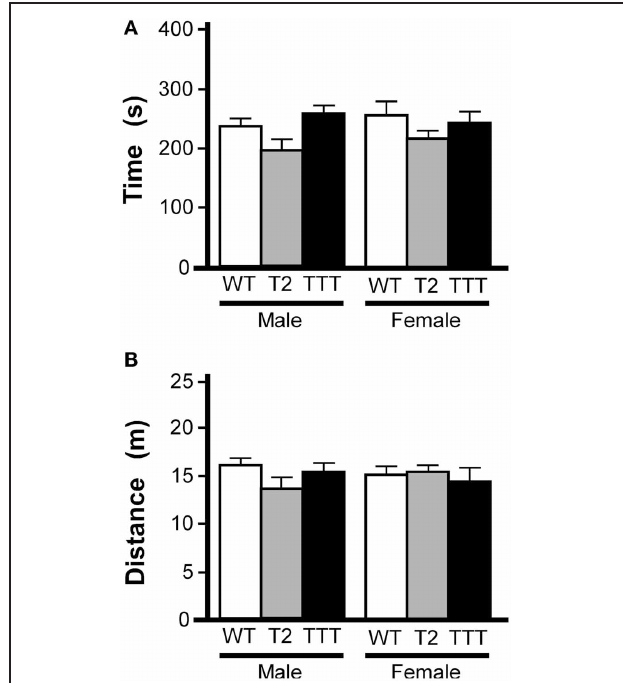
FIGURE 3 | Light/dark box behavior in mice lacking Trek channels. Wild-type (WT, white), Trek2 − / − (T2, gray), and Trek1/2 / Traak − / − (TTT, black) mice were evaluated in a 10min (600s) light/dark box test ( n = 5–12 per group). (A) Time spent in the light compartment; no genotype-dependent differences were observed for male [ F ( 2 , 22 ) = 2 . 7, P = 0 . 09] or female [ F ( 2 , 25 ) = 1 . 0, P = 0 . 38] mice. (B) Distance traveled in the light compartment; no genotype-dependent differences were observed in male [ F ( 2 , 22 ) = 1 . 7, P = 0 . 21] or female [ F ( 2 , 25 ) = 0 . 2, P = 0 . 82] mice.